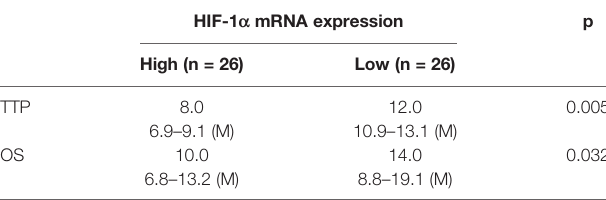
TABLE 2 | HIF-1 a expression and clinical outcome of Sorafenib